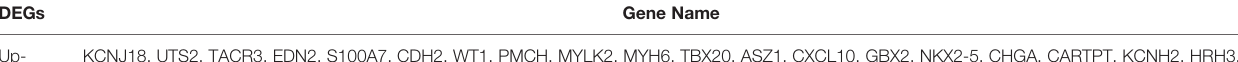
TABLE 1 | Sixty-one angiogenesis-related differentially expressed genes (DEGs) identi fi ed in the TCGA dataset in breast cancer patients. DEGs Gene Name